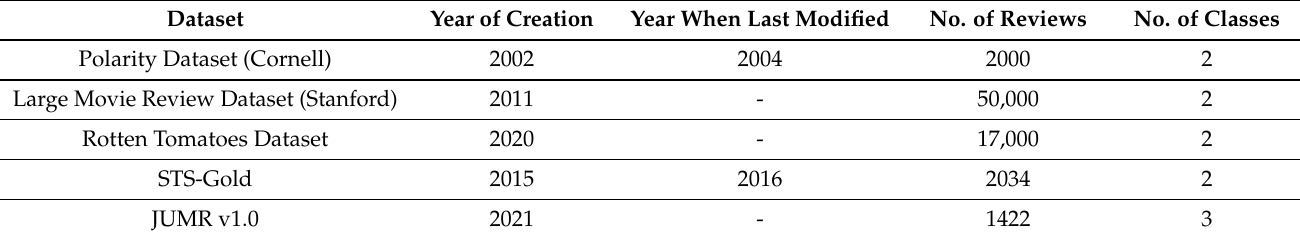
Table 2. How JUMRv1 compares to popular movie review datasets.